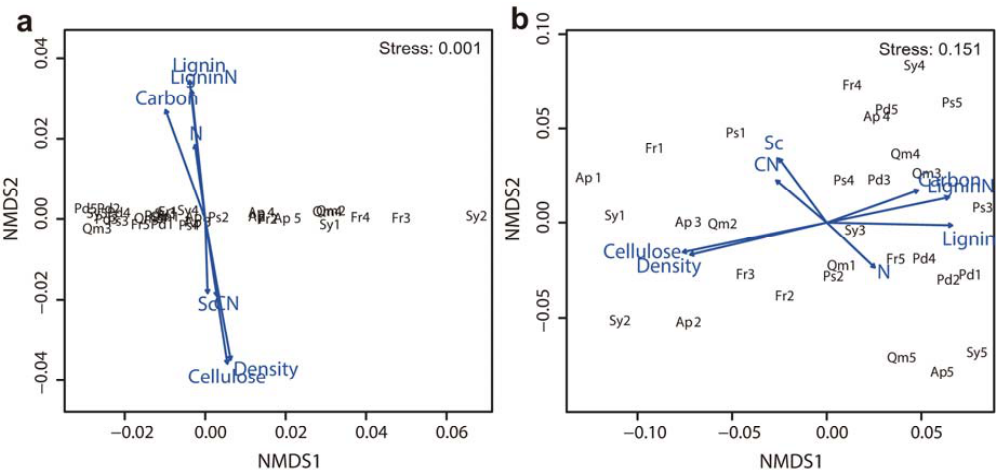
Figure 4. NMDS ordination biplot based on the mass loss of branch wood for six tree species ( a ) during the early stage of decomposition (from the beginning of decomposition to 9 months) and ( b ) during the entire decomposition period of 40 months ( n = 5). Angles and lengths of radiating arrows indicate the direction and strength, respectively, of the relationships between litter quality parameters. See abbreviation in Figure 3.